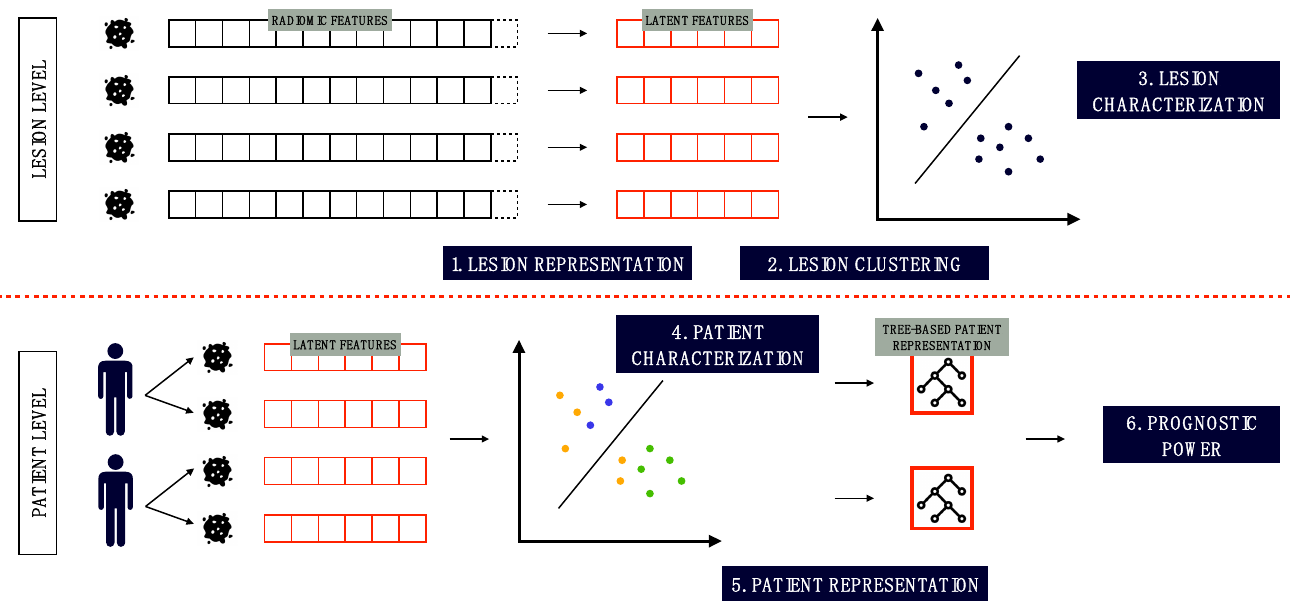
Figure 1. Flowchart of the analyses: at the lesion level, lesions are (1) represented through an agnostic dimensionality reduction of radiomic vectors and (2) clustered in groups, which are further analyzed with clinical variables (3). At the patient level, patients are qualitatively described in terms of intra-patient heterogeneity (4), represented through trees (5), and quantitively analyzed with prognostic purposes (6).